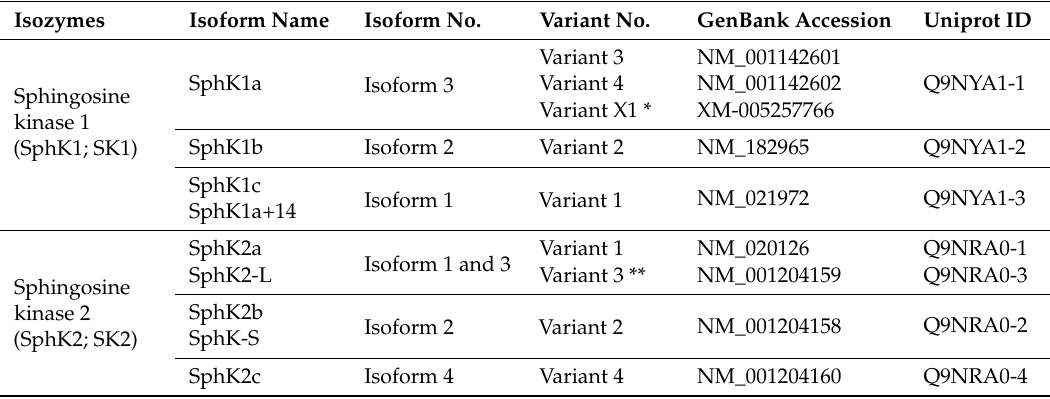
Table 2. Nomenclature of SphK1 and SphK2 isozymes and protein